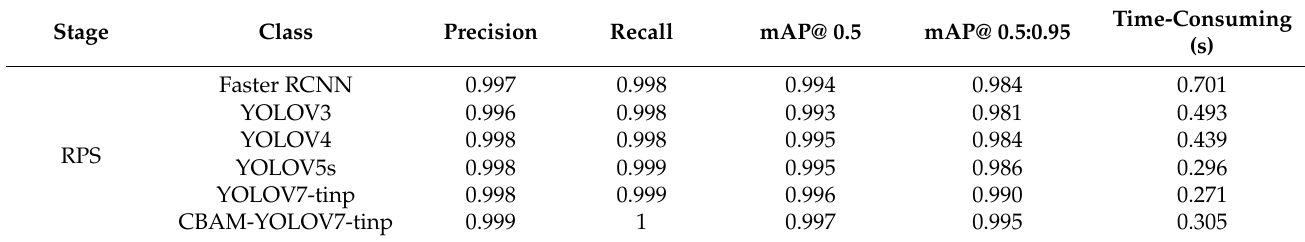
Table 4. Comparison of different recognition methods in